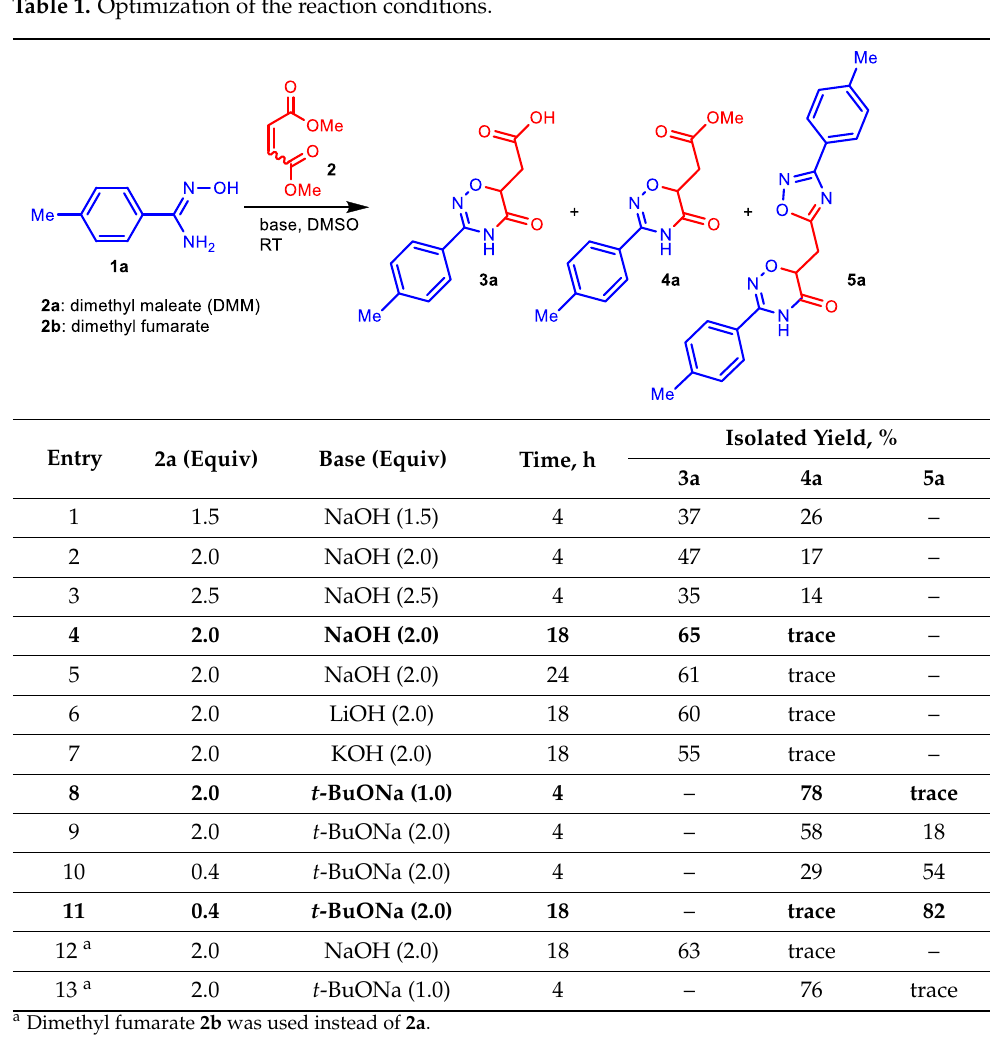
Table 1. Optimization of the reaction conditions.